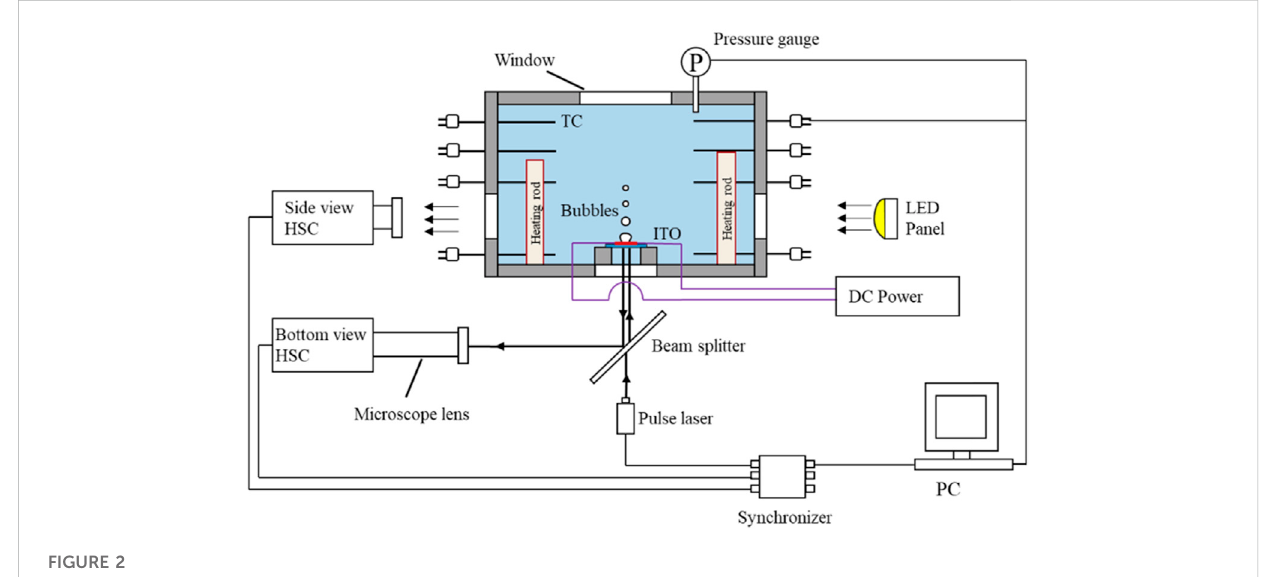
FIGURE 2 Schematic of the experimental system.